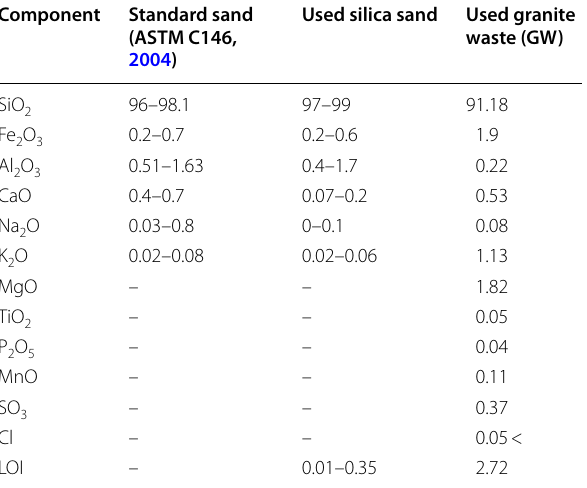
Table 3 Physical and chemical specifications of the